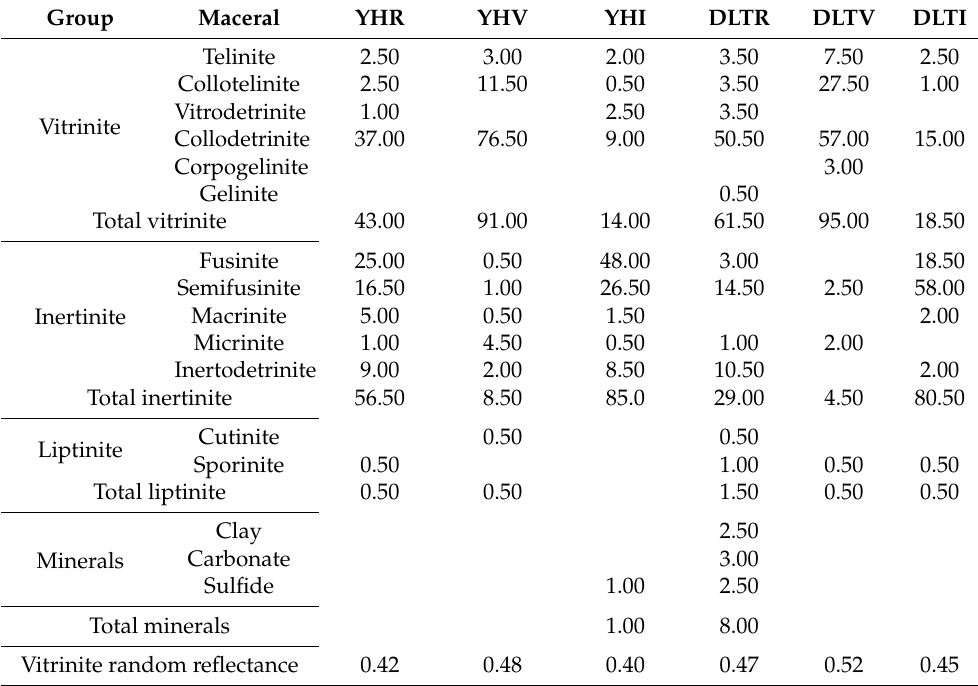
Table 3. Maceral composition and vitrinite reflectance of samples (vol. %; on a mineral